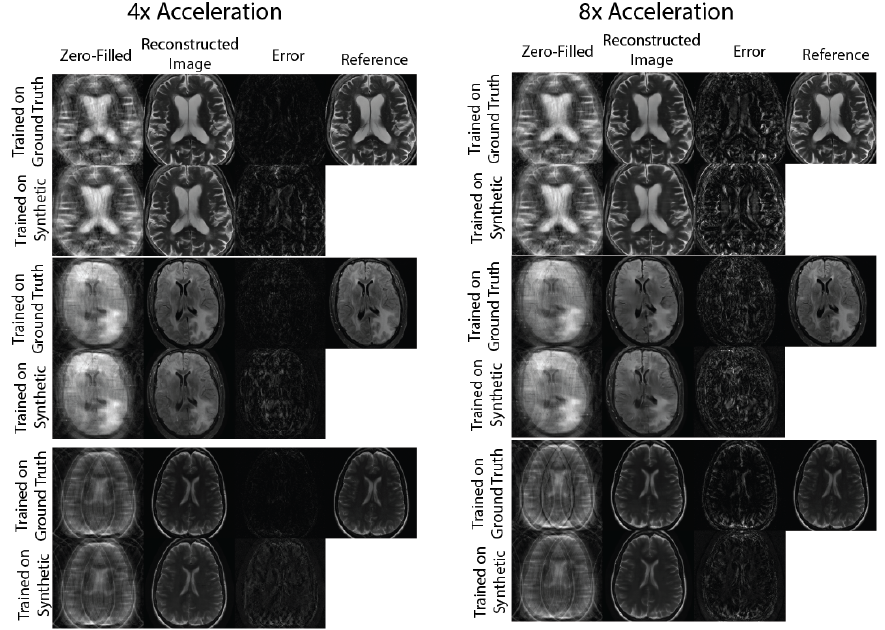
Figure 3. Sample image comparisons at 4 × and 8 × acceleration factors for the 20-coil dataset. The columns compare the zero-filled image, reconstructed image, and error maps generated with 2 Variational Networks trained on ground truth and synthetic k